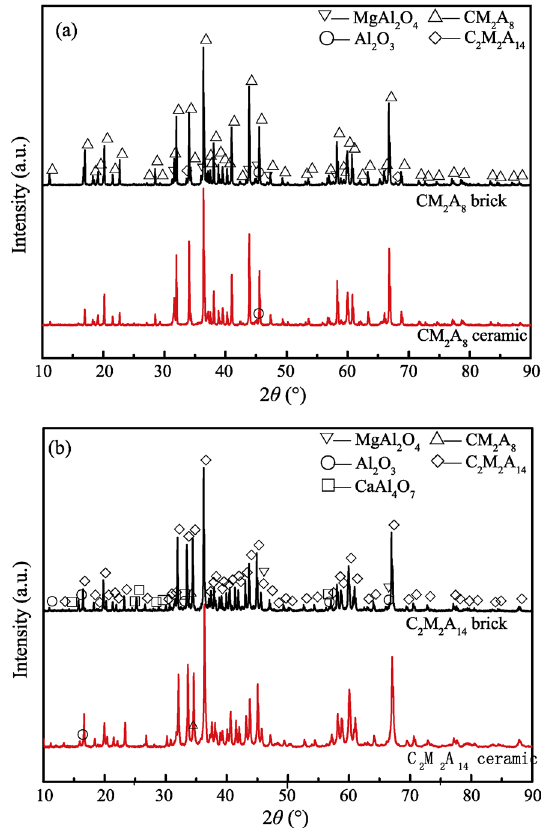
Fig. 2 XRD patterns of CM 2 A 8 and C 2 M 2 A 14 bricks and ceramics: (a) CM 2 A 8 brick and ceramic, (b) C 2 M 2 A 14 brick and